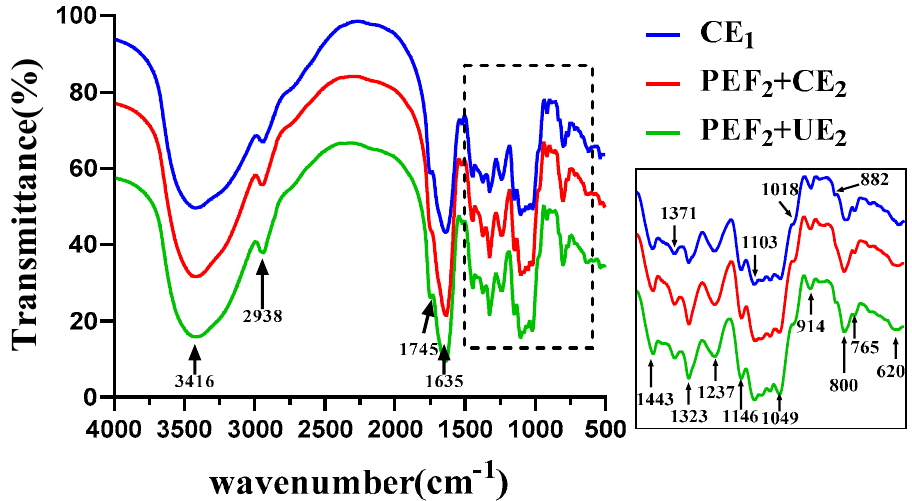
Figure 7. The FT − IR spectra of Se − TPSs obtained using different extraction methods and studied in the range of 200~400 nm.